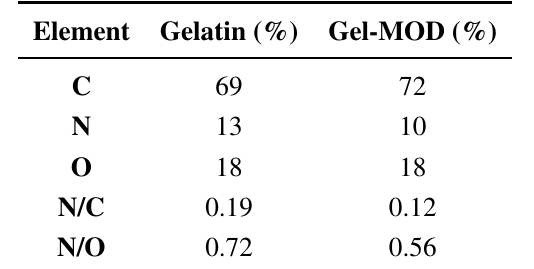
Table 2. Atomic surface composition (in atomic %) of gelatin and methacrylamide-modified gelatin (gel-MOD) obtained by means of X-ray photoelectron